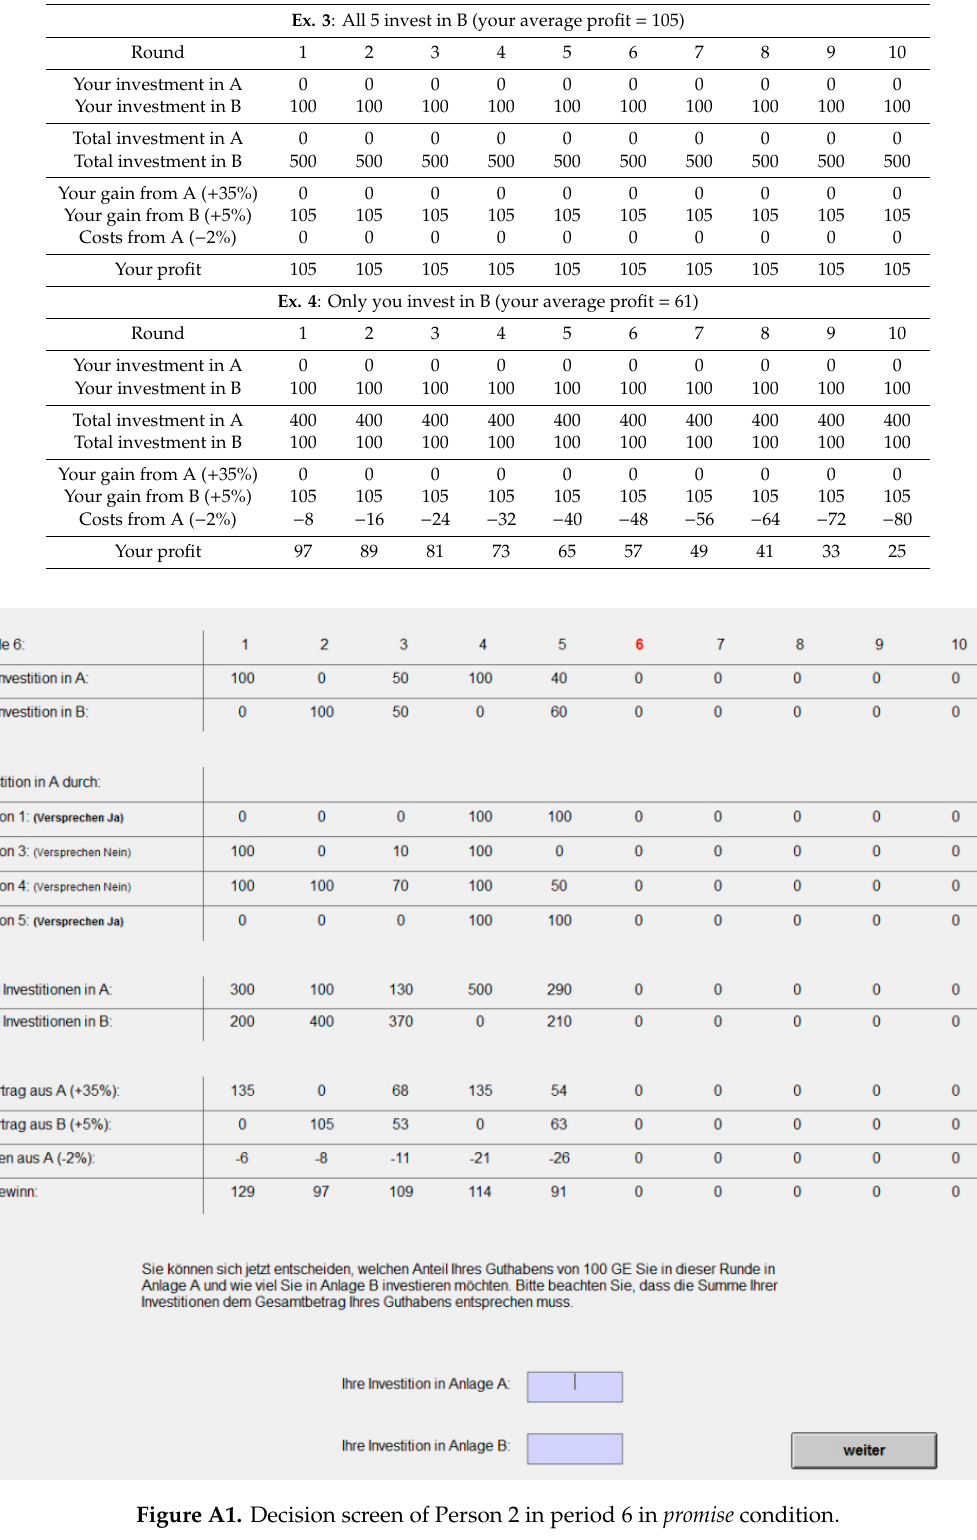
Figure A1. Decision screen of Person 2 in period 6 in promise condition.